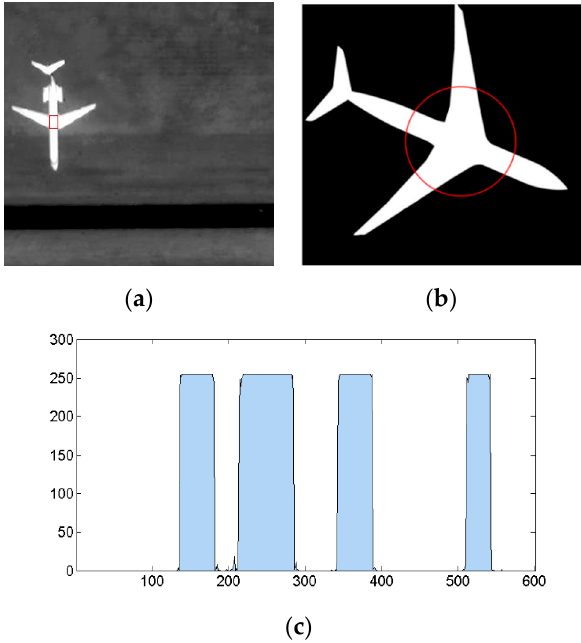
Figure 2. ( a ) The rectangle of the intersection of the aircraft fuselage and the wingspan. ( b ) The circumference on the aircraft, the size of the original image is 1024 × 958, the radius of the circle is 200 pixels. ( c ) The gray value curve on the circumference, the horizontal axis is 601 pixels, and the vertical axis is the gray value at each pixel point.